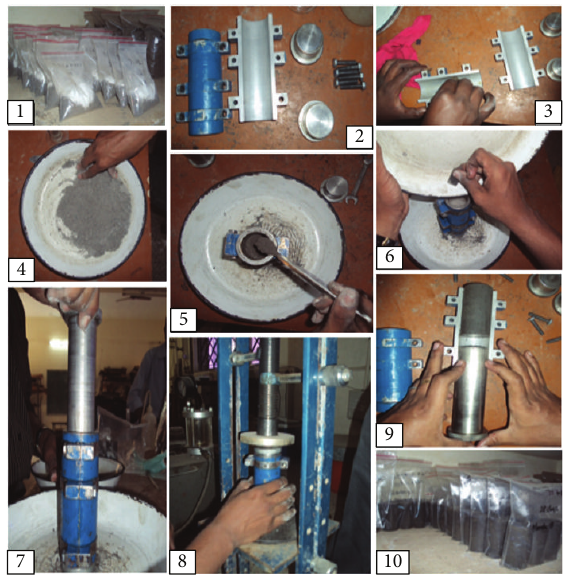
Figure 2: Preparation and curing of UCC test samples.